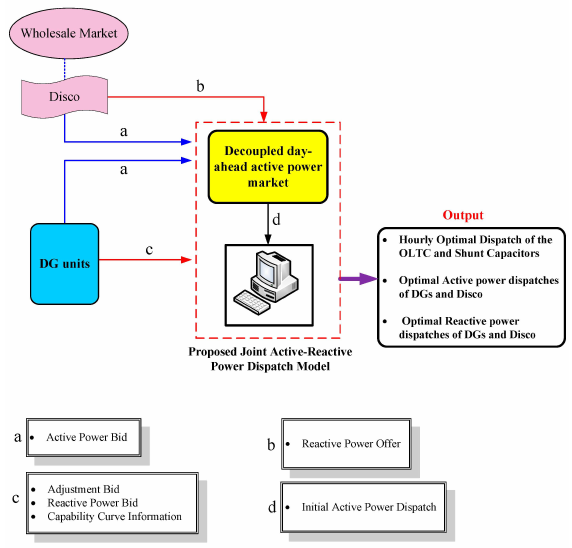
Figure 4. Structure of proposed joint active/reactive power dispatch